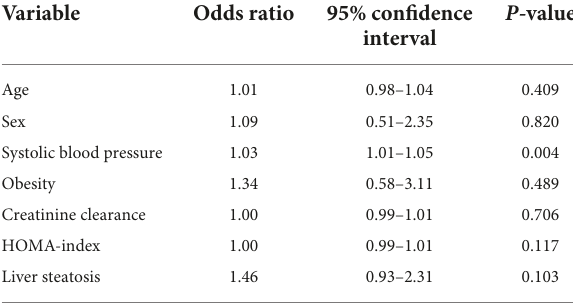
TABLE 6 Logistic regression analysis with left ventricular hypertrophy as the dependent variable and inclusion of the homeostatic model assessment (HOMA) index as an independent variable.